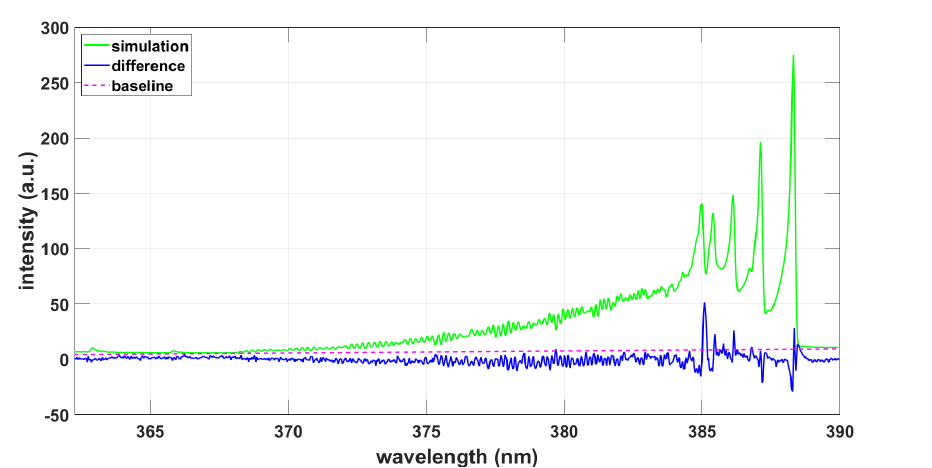
Figure 8. Simulation using ExoMol data and the NMT program, T = 9090 K, ∆ λ = 0.11 nm.